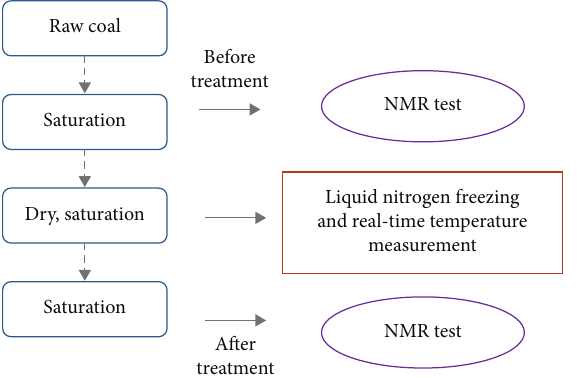
Figure 4: Experimental flow